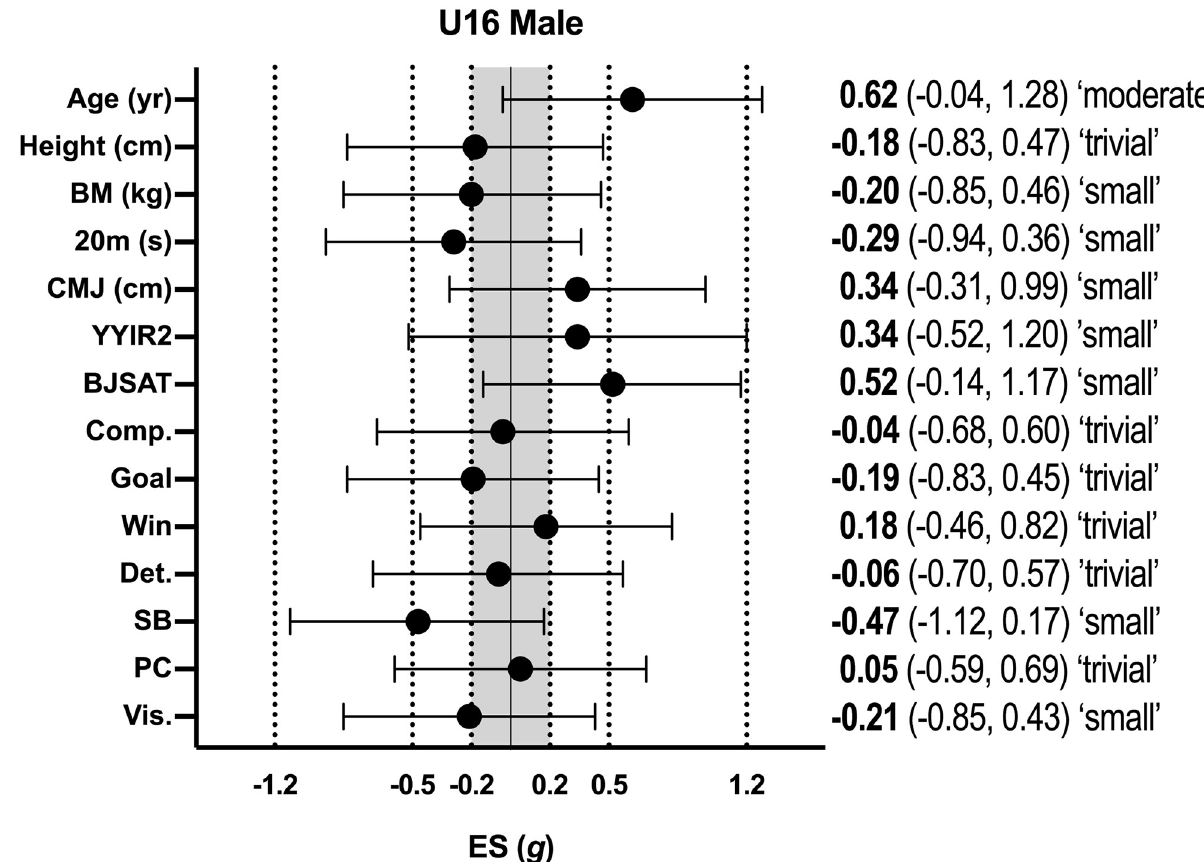
Fig 1. Effect sizes between selected and non-selected male U16 basketballers. BM–body mass; CMJ–countermovement jump; YYIR2 –Yo-Yo Intermittent Recovery Test Level 2; BJSAT–Basketball Jump Shooting Accuracy Test: DM–decision-making; Comp–competitiveness; Det.– determination; SB–self-belief; PC–positive cognition;